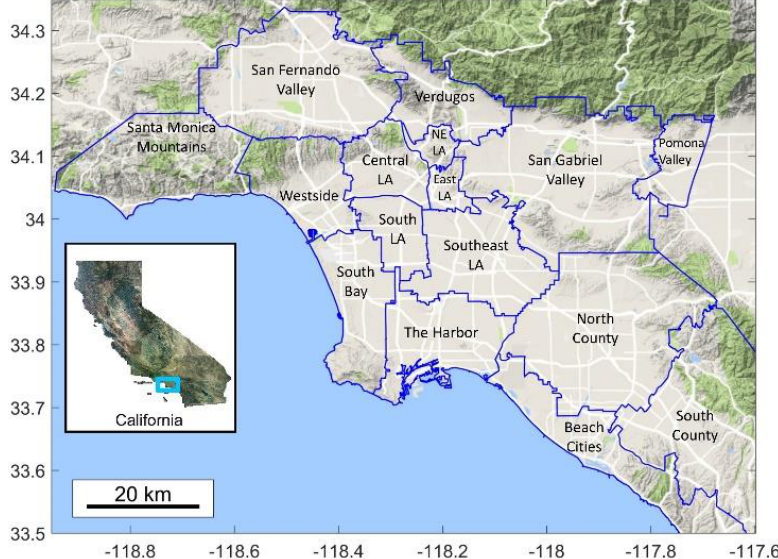
Figure 1. Los Angeles county study area in California with boundaries of 16 local regions delineated by blue boundaries and used in statistical analyses of heat vulnerability.